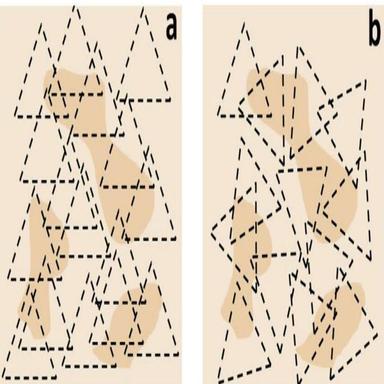
Schematic illustration of different sampling templates for computing Pn functions (in the case of n ¼ 3) from images: (a) Isotropic sampling, in which both the location and orientation of the polygon template are randomly selected. (b) Directional sampling, in which only the location of the template is randomly selected.